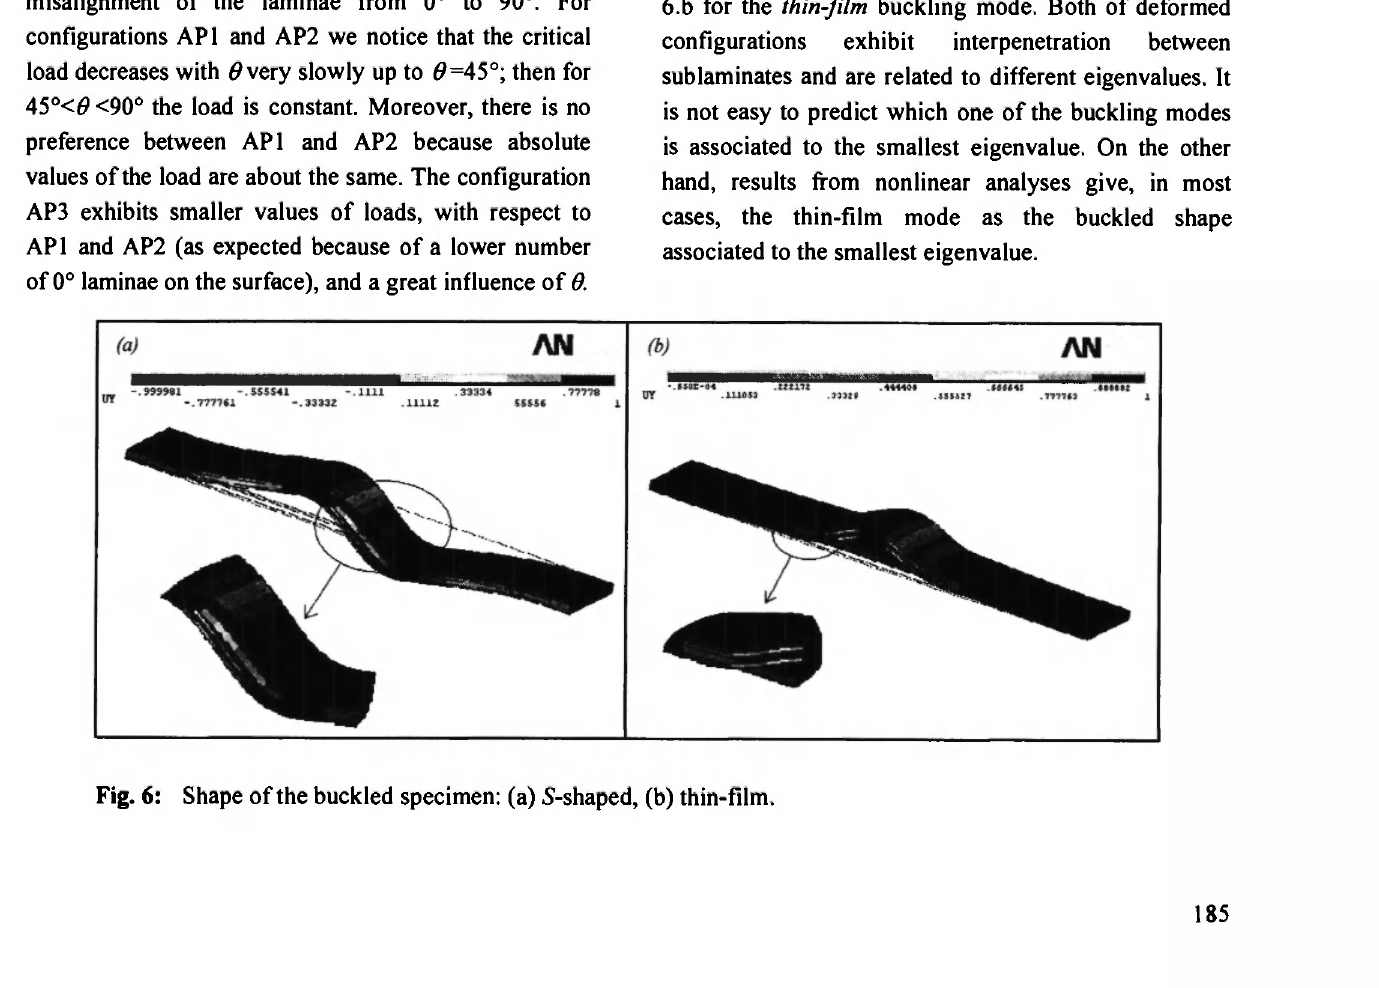
θ [·] Fig. 5: Absolute buckling load versus angle of misalignment.